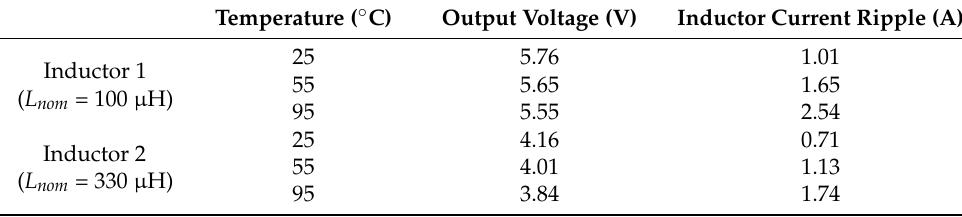
Figure 8. Experimental measurement of the diode voltage (blue), output voltage (green) and inductor current in AC coupling (red) for different inductors and temperature conditions. First row depicts measurement conducted on inductor 1 ( L nom = 100 µ H) for F s = 38 kHz, with a mean inductor current of 3.2 A at: ( a ) 25 ◦ C, ( b ) 55 ◦ C, ( c ) 95 ◦ C. Second row depicts measurement conducted on inductor 2 ( L nom = 330 µ H) for F s = 18 kHz, with a mean inductor current of 1.7 A at: ( d ) 25 ◦ C, ( e ) 55 ◦ C, ( f ) 95 ◦ C. Table 2. Experimental measurement for different inductors and temperature